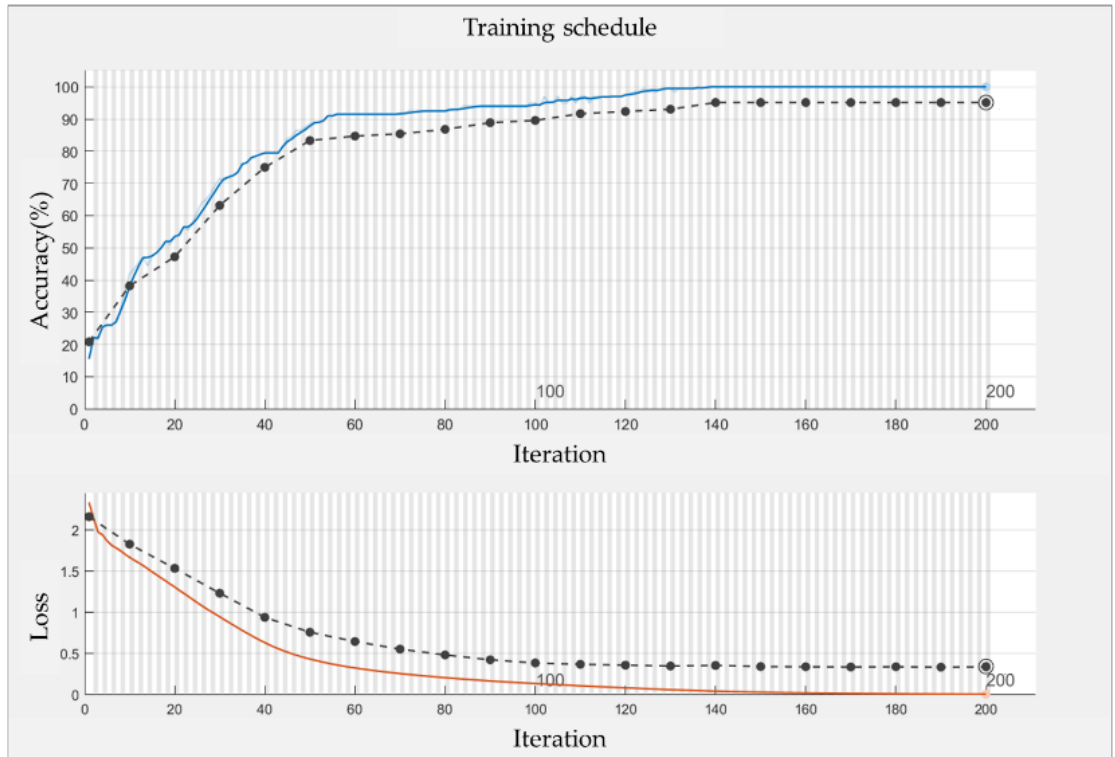
Figure 8. The training process of the